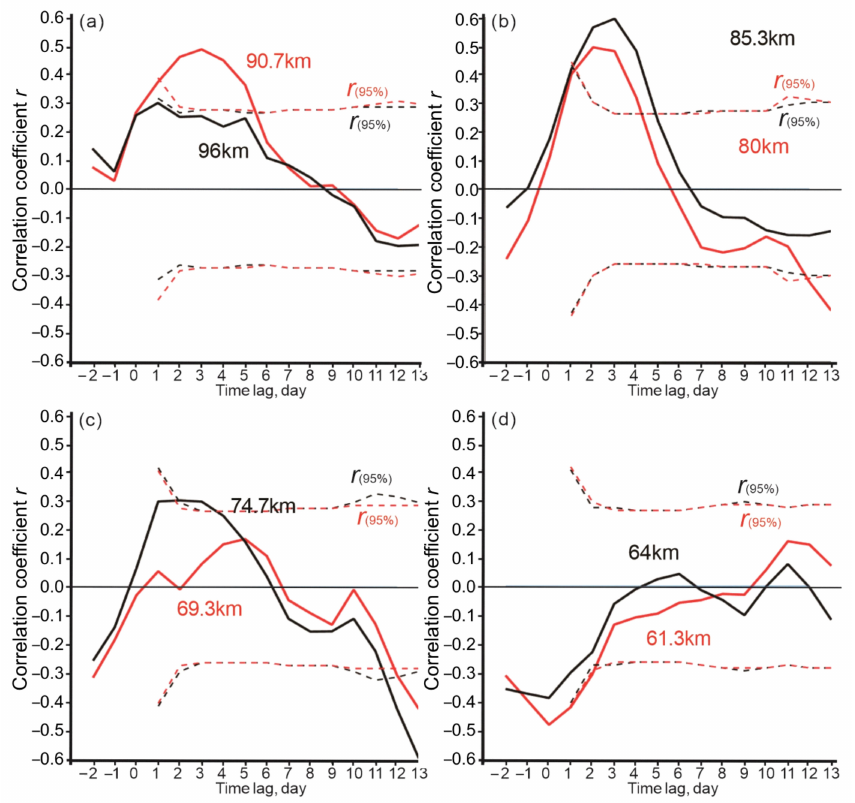
Figure 7. Family of moving correlation curves with time lags of the wave 1 amplitude (Z1) relative to the wave 2 amplitude from –2 days to +13 days. The eight MLS pressure levels in the mesosphere– mesopause region between 61 km and 96 km are presented: ( a ) 90.7 and 96.0 km, ( b ) 80.0 and 85.3 km, ( c ) 69.3 and 74.7 km and ( d ) 61.3 and 64.0 km. The 95% confidence limits are shown by dashed